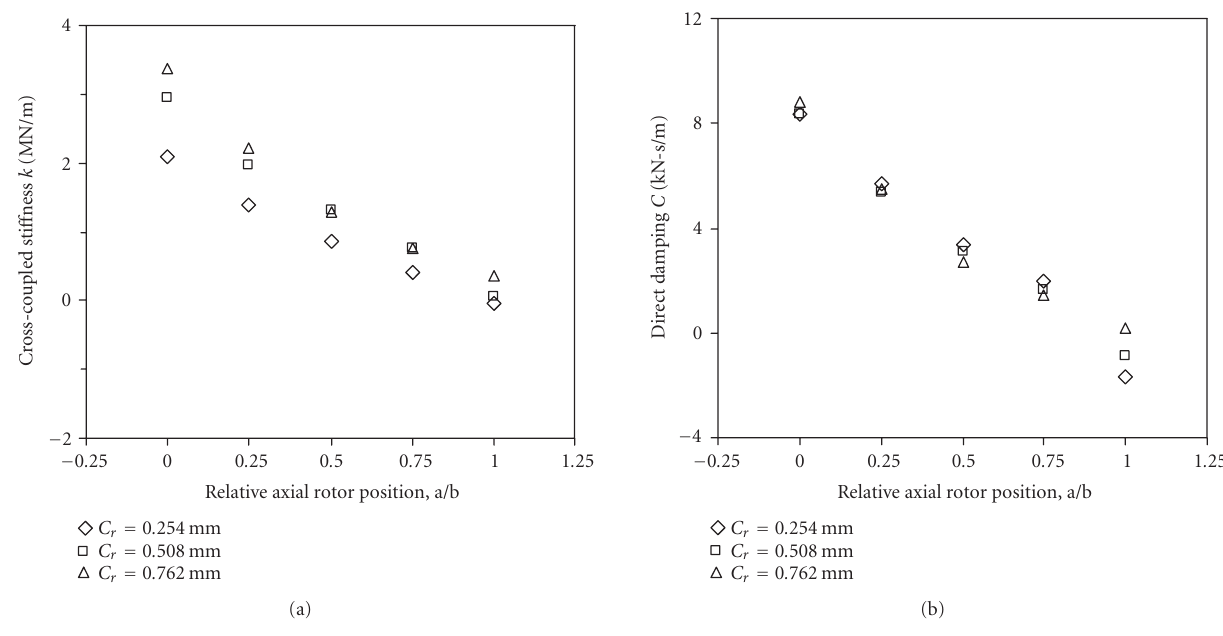
Figure 6: Predicted tangential force coe ffi cients versus relative axial rotor position a/b for high-low seals: (a) cross-coupled sti ff ness; (b) direct damping.